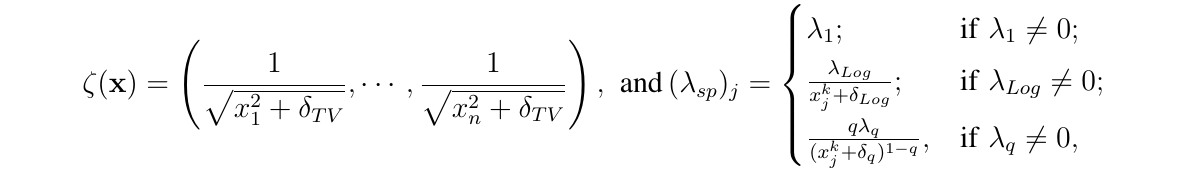
Algorithm 1: Uniform Optimization Transfer